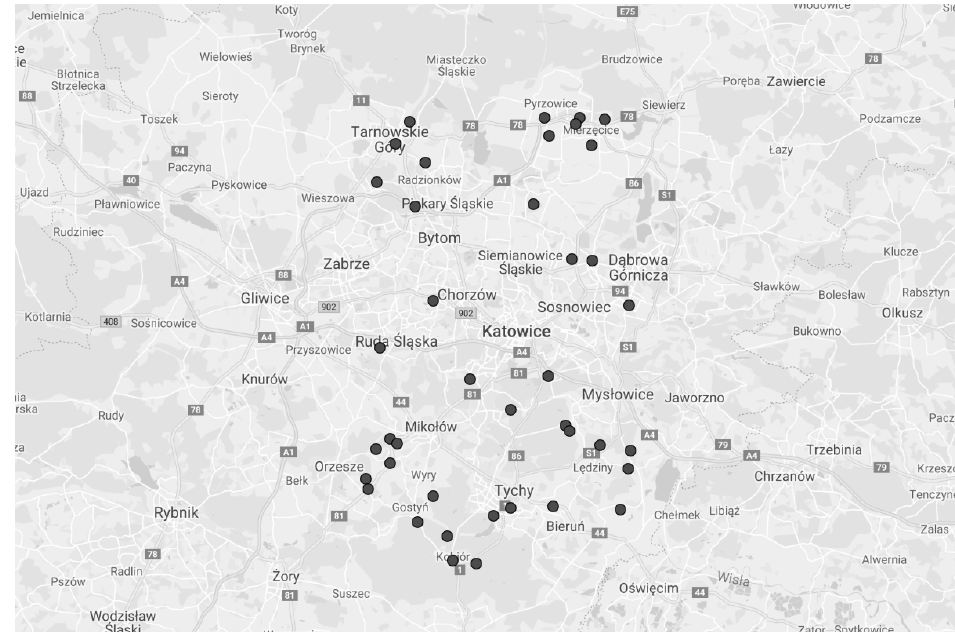
Figure 1. The map for case study with the points to